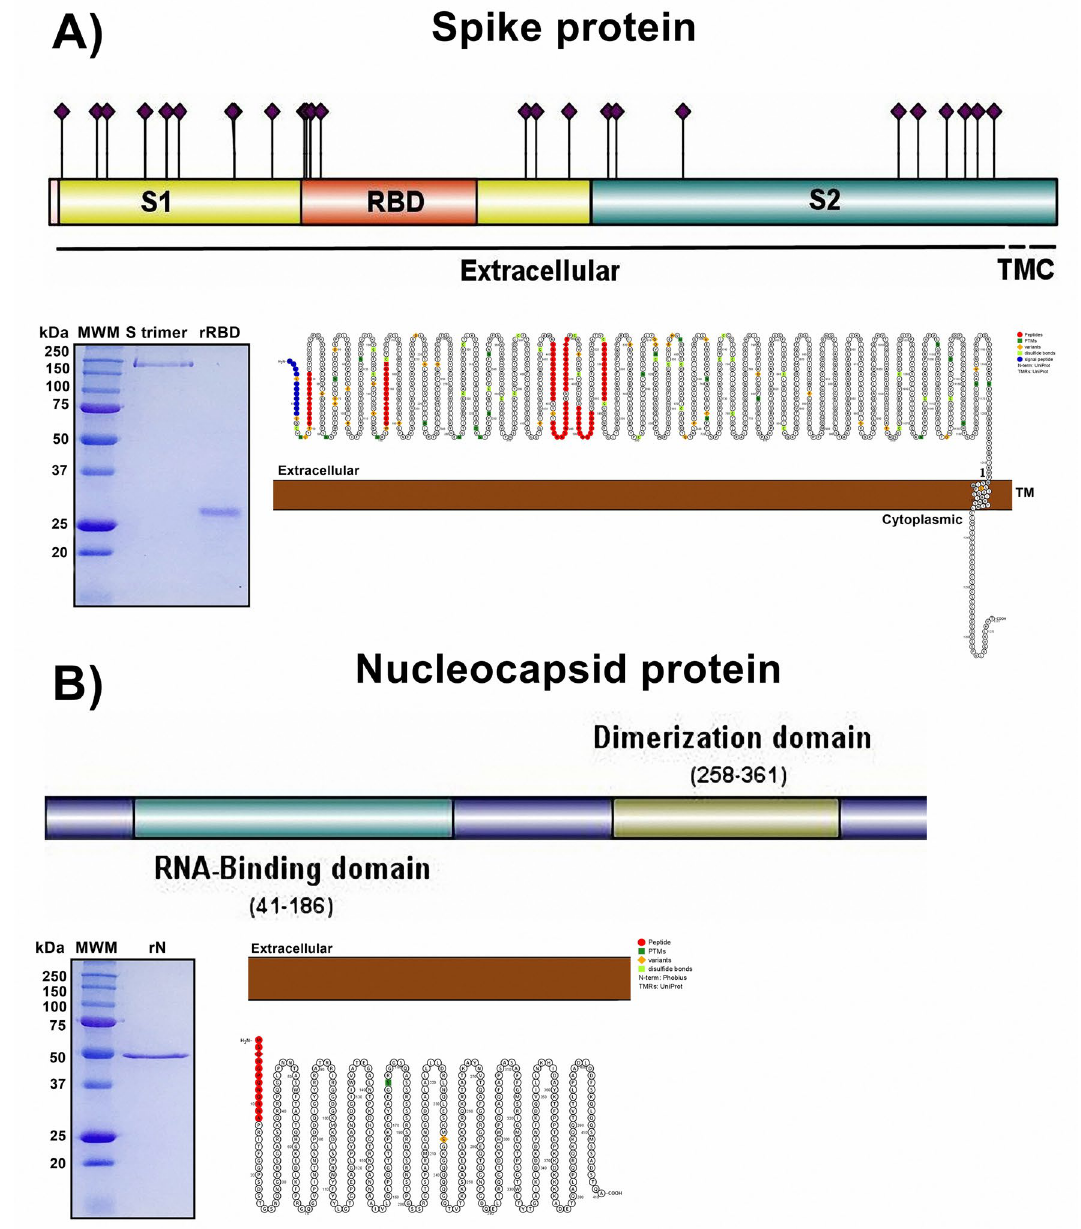
Figure 2. Recombinant proteins of the spike glycoprotein and nucleocapsid of SARS-CoV-2 were obtained, and the primary and secondary structures were analyzed. ( A ) Spike protein. Upper panel and lower right panel, analysis of the primary and secondary amino acid sequences showing the extracellular, TM (transmembrane) and cytoplasmic ( C ) localization of each amino acid. Purple diamonds represent glycosylated residues. ( B ) N protein. Upper panel and lower right panel showing analysis of the primary and secondary amino acid sequences with intraviron localization, phosphorylated amino acids, RNA-binding and dimerization domains. In both proteins, selected peptides are shown in red in 2D structure, and the peptide signal is marked in blue. Middle panel in ( A ) and ( B ): electrophoresis and Coomassie blue staining of recombinant RBD, S trimer, or N. MWM molecular weight